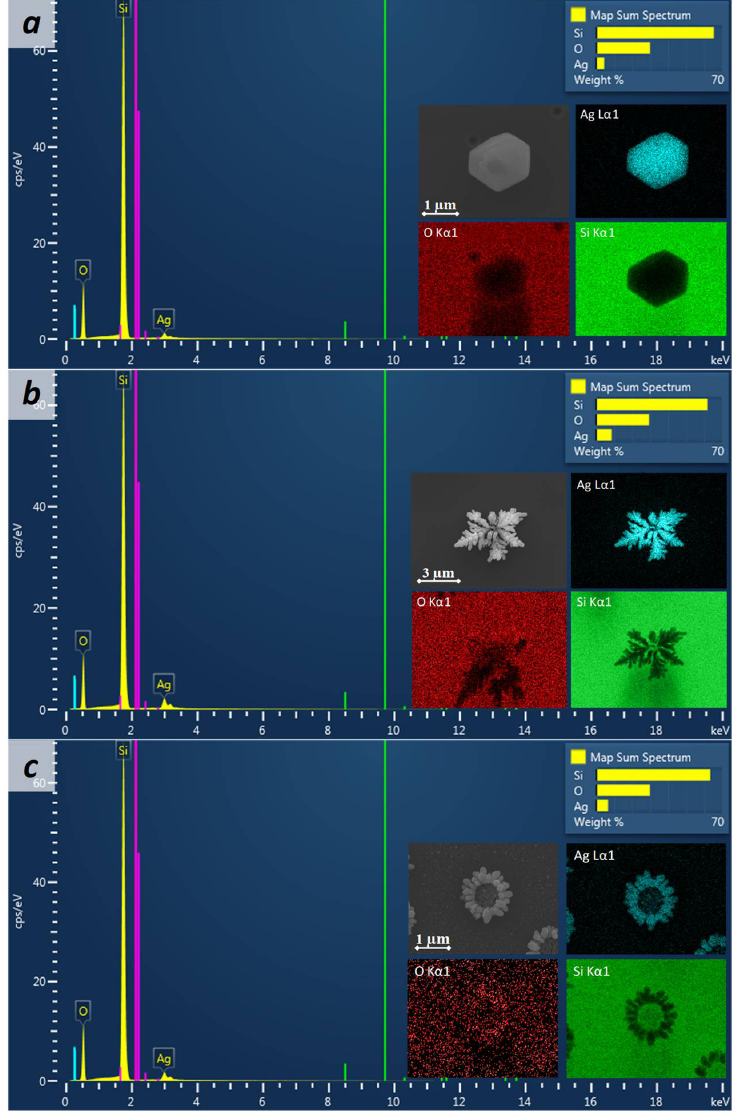
Figure 3. EDX-spectra, SEM and EDX maps of SiO 2 (Ag)/Si with Ag crystal ( a ), dendrite ( b ), and “sunflower-like” ( c ) structures.